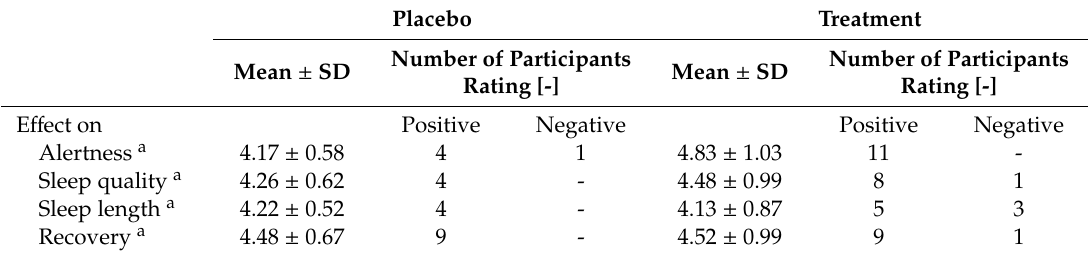
Table 1. Assessment of participants’ retrospective results of both light glasses ( N =